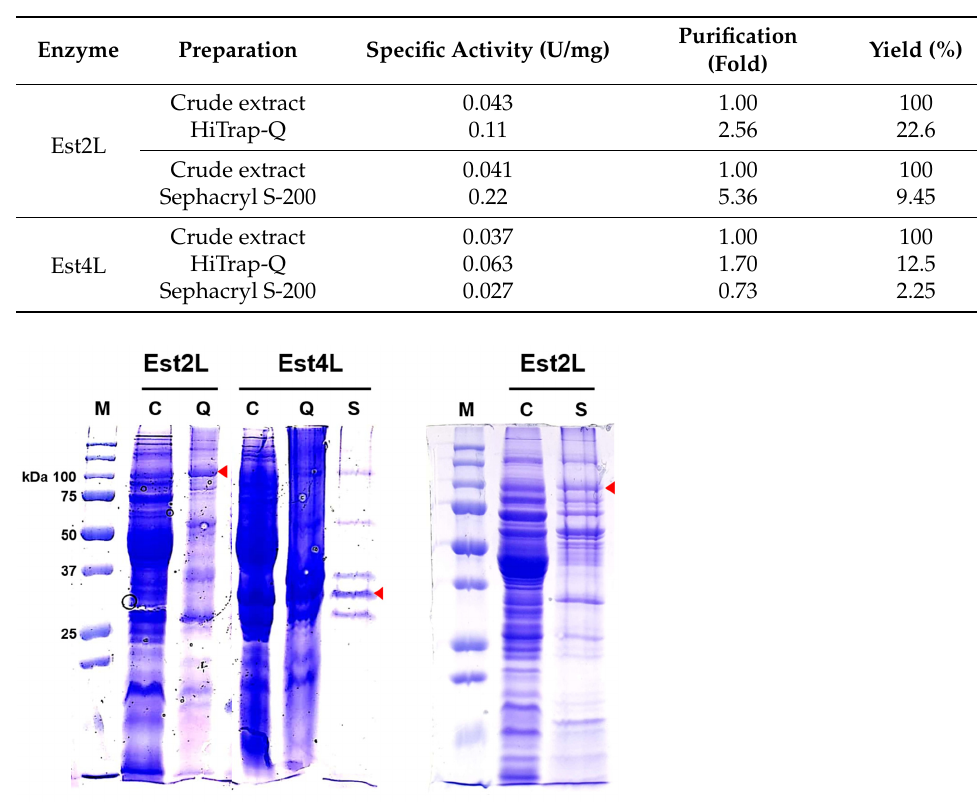
Figure 2. HiTrap-Q chromatograms of crude extracts of E. coli DH5 α strains harboring a plasmid pUC19 as a control and recombinant plasmids SKE2 and SKE4 as sources for esterases Est2L and Est4L, respectively. The different volume of each fraction was appropriately measured for the esterase activity. Activity was calculated as dA/min, then divided by the volume of the fraction, and finally expressed as dA/min/mL on the Y -axis. The chromatogram of UV absorbance (blue line) at 280 nm (A.U.) of Est2L was added along with conductivity (red line) (mS/cm). The UV chromatograms of Est4L and pUC19 samples were similar to that of Est2L. Protein concentrations of the highest active fractions of Est2L, Est4L, and pUC19 samples were 1.8, 1.4, and 1.6 mg/mL, respectively. Table 1. Specific activities and yields of Est2L and Est4L during separation.